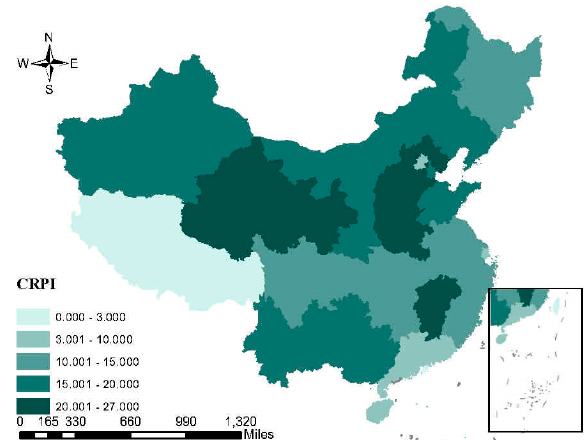
Figure 4. The spatial distribution of average annual economic contribution rate (CRPI) of six polluting industries in China. Source: Calculated by the authors on the basis of the Environmental Statistics Yearbook of China, 2005–2015. Int. J. Environ. Res. Public Health 2020 , 17 , x FOR PEER REVIEW